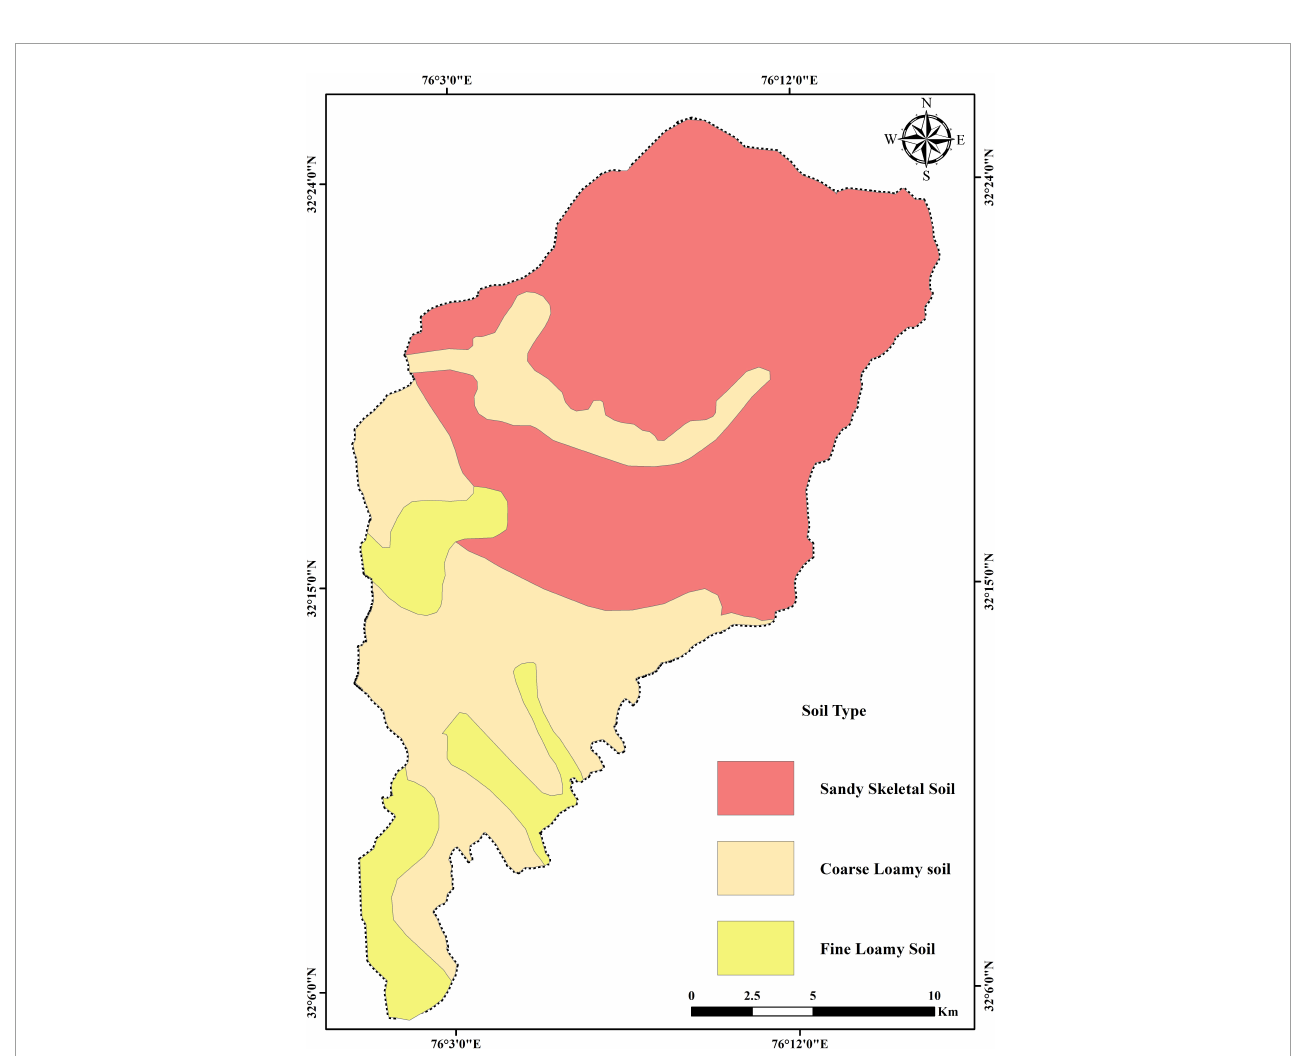
FIGURE4 Map showing different soil types in the Dehar